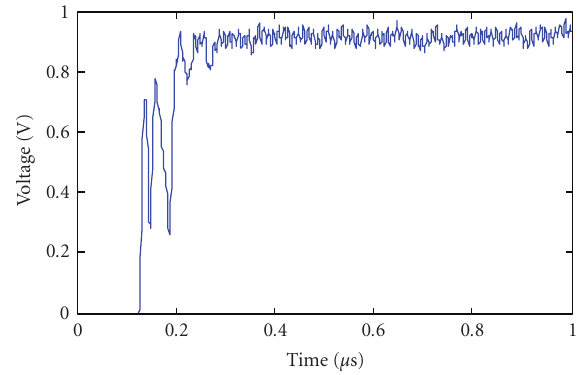
Figure 13: Standard deviation of 1000 traces, sampling frequency 100 MHz and 25